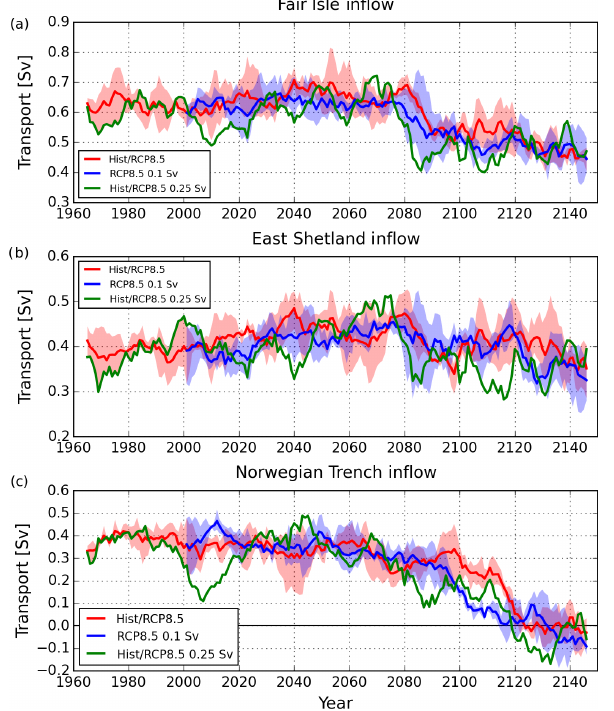
Figure 14. Volume transport during winter (DJFM) of the main Atlantic inflow branches to the northern North Sea: Fair Isle Cur- rent (a) , East Shetland flow (b) , inflow along the western side of the Norwegian Trench at 60.4 ◦ N (c) . Solid: ensemble means of exper- iments E0 (red) and E010 (blue) and a single realization of experi- ment E025 (green). Shaded areas: ensemble spread.